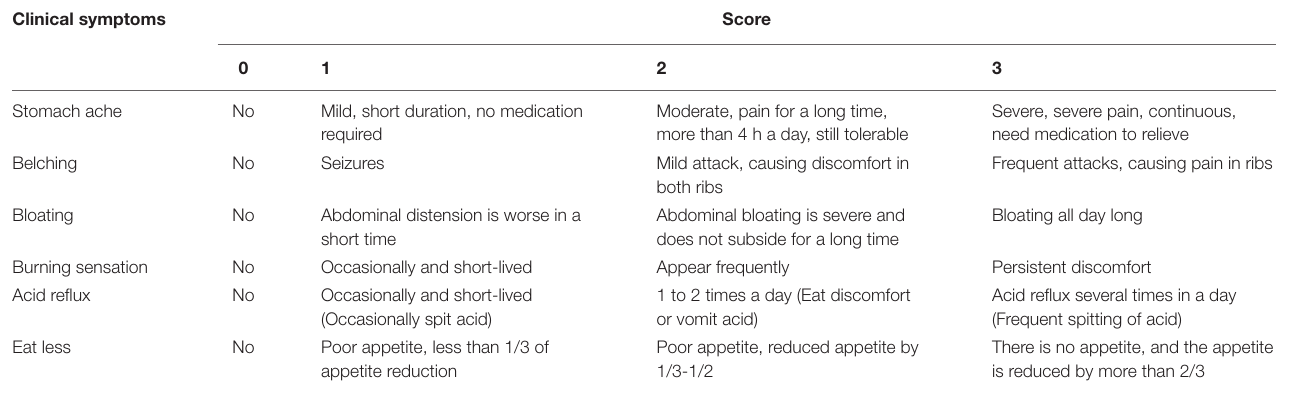
TABLE 1.2 | Gastrointestinal symptom score